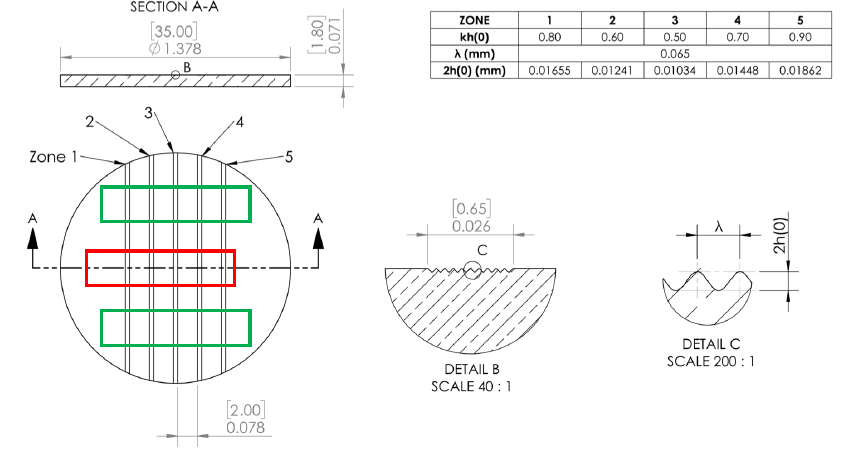
Figure 1. Target geometry with multiple surface perturbations on the copper sample used for the gun-drive experiments. The red region represents the area implanted with helium, whereas the green area shows the region used to extract data corresponding to unimplanted copper. Please note that the dimensions on the actual drawing are in inches with mm in square